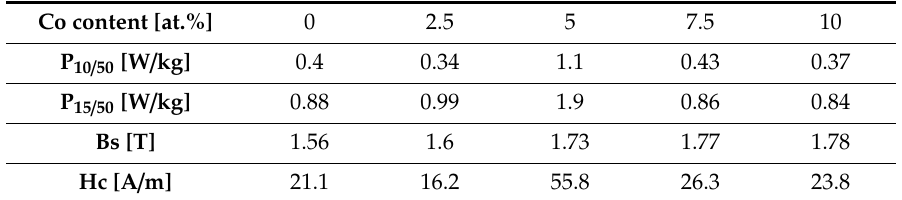
Table 1. Core power losses for annealed at 310 ◦ C toroidal cores measured at 1 T / 50 Hz (P10 / 50), 1.5 T / 50 Hz (P15 / 50), saturation magnetization Bs and coercivity Hc.